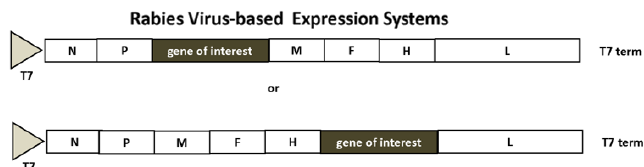
Figure 3. Measles Virus-Based Expression system. The measles virus structural proteins are flanked by T7 RNA polymerase promoter and the T7 RNA polymerase terminator. Foreign genes can be inserted between the P and M or H and L genes. H, MV hemagglutinin; L, MV L protein; M, MV matrix protein; N, MV nucleocapsid protein; T7, T7 RNA polymerase promoter; T7 term, T7 RNA polymerase terminator.